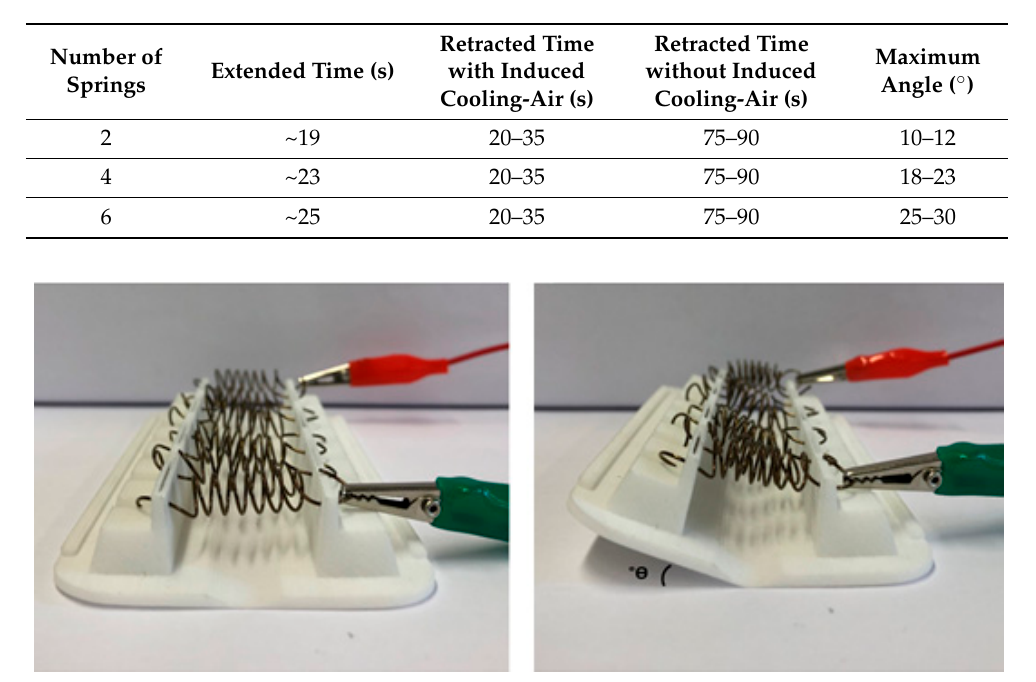
Figure 9. Prototype with six springs and heating system (across different points). Table 3. Extended and retracted time with and without induced cooling and maximum angle of inclination.